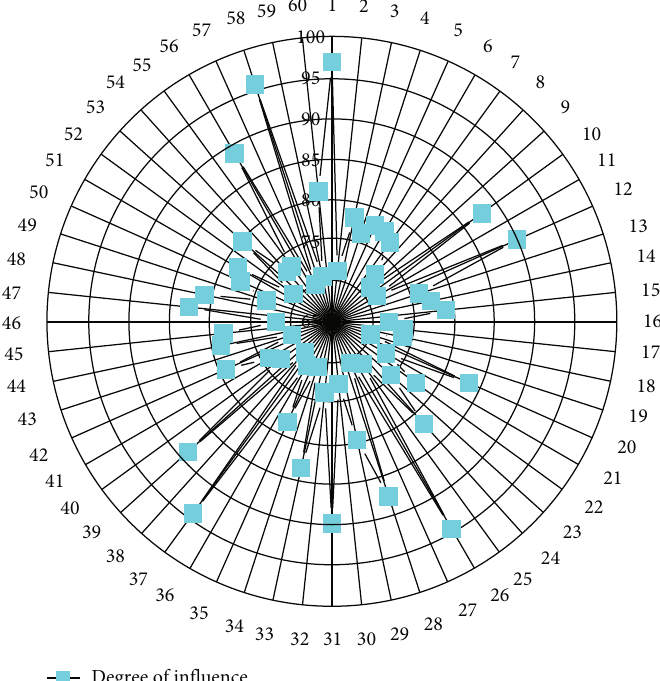
Figure 2: The in fl uence of the Lacanian unconscious on the subject.